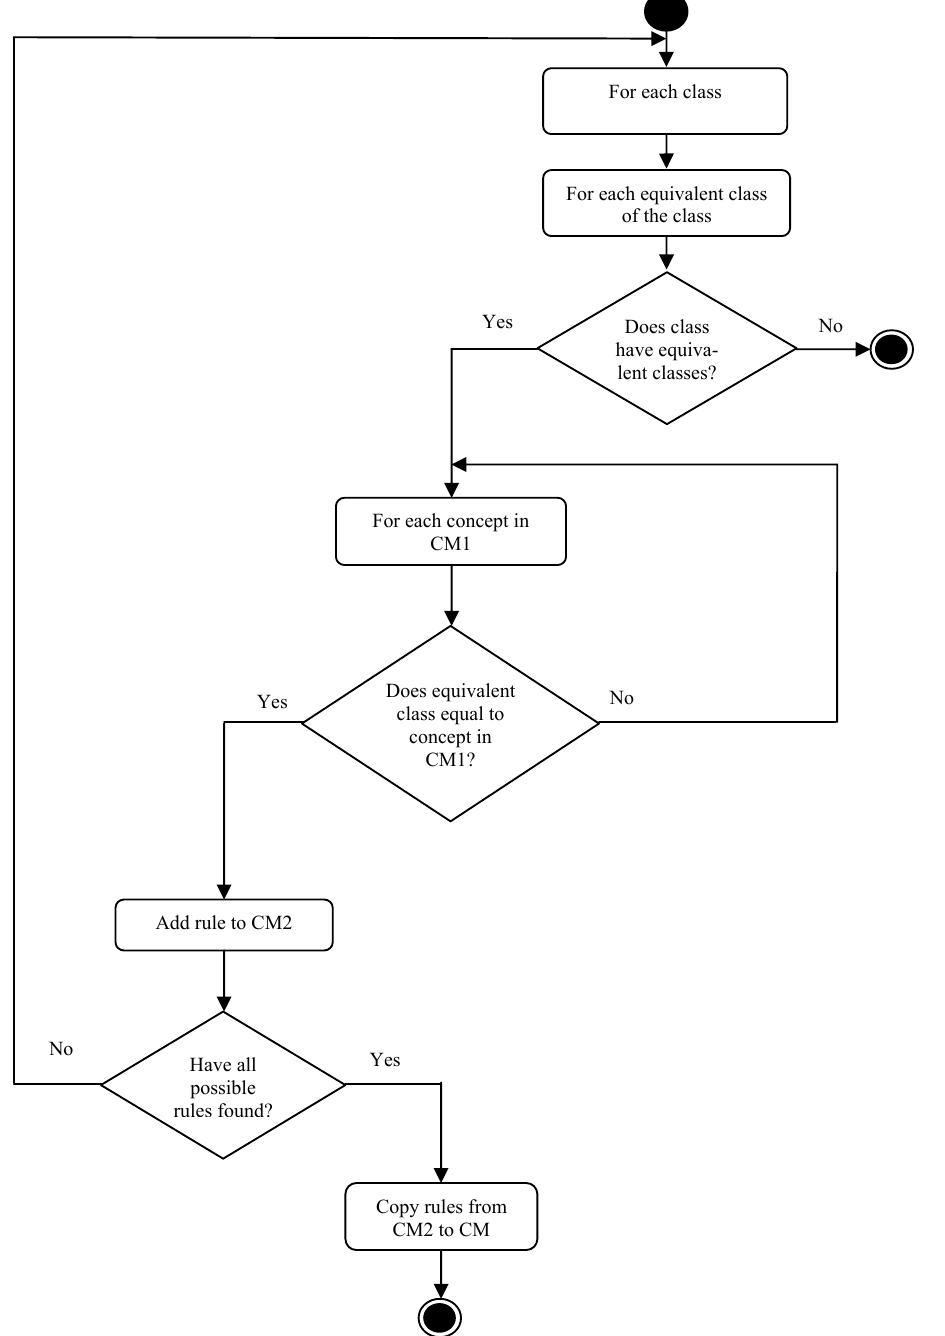
Fig.3. Ontology transformation step